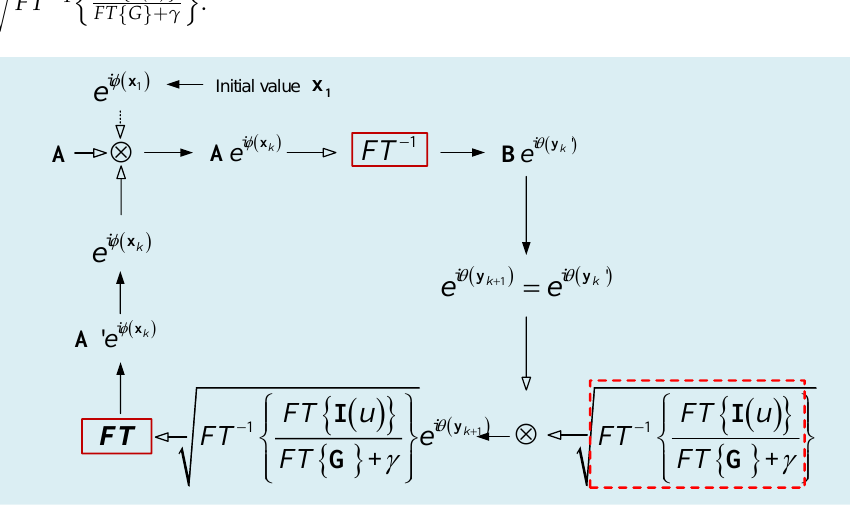
Figure 2. Illustration of the iterative-transform jitter-robust phase retrieval wavefront sensing.